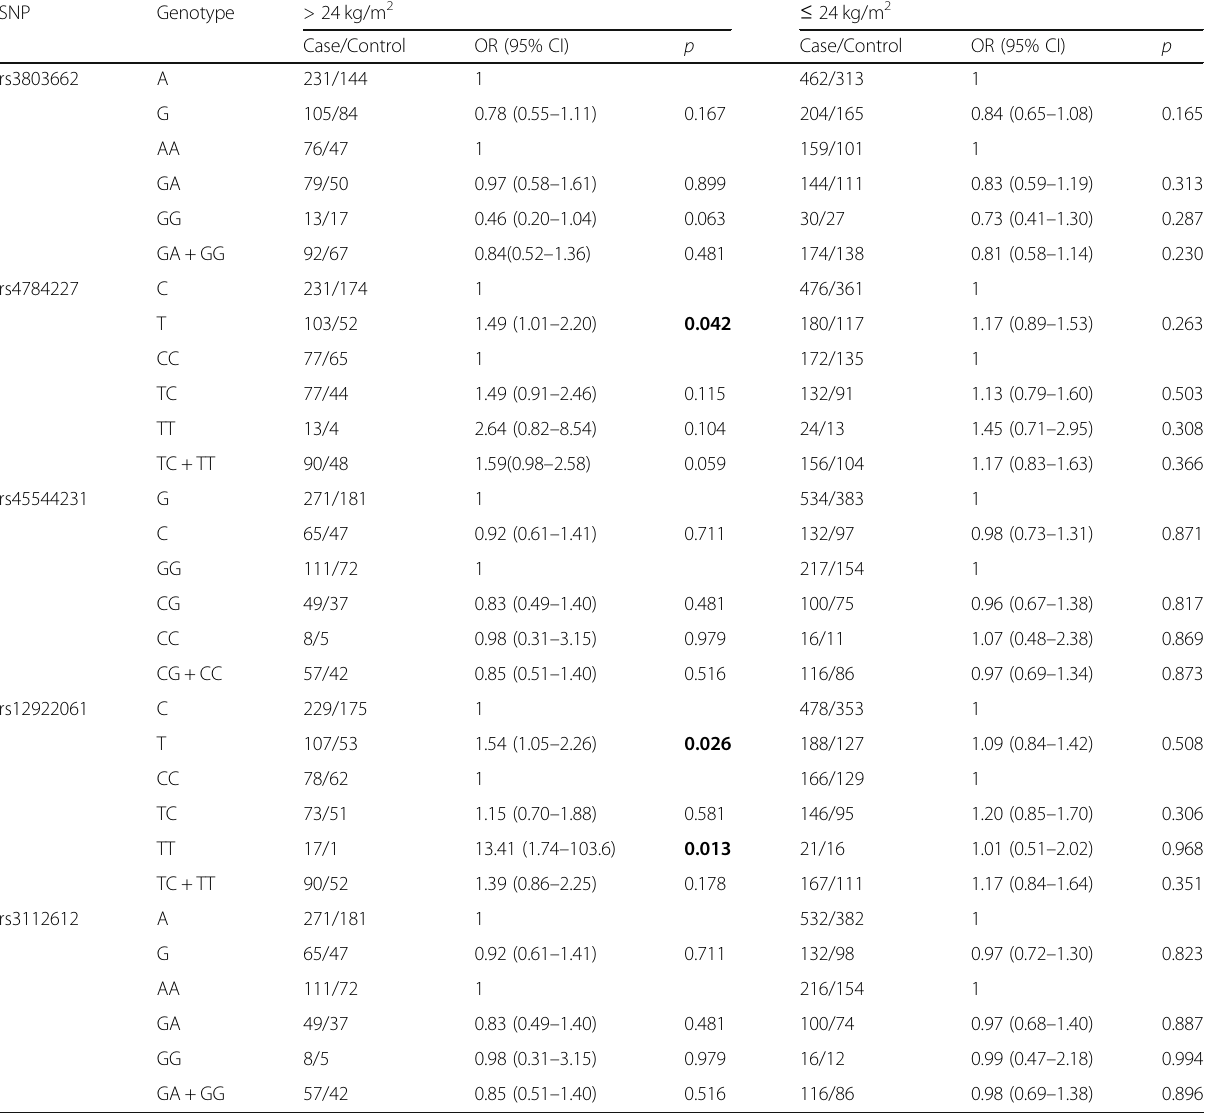
Table 6 The associations between CASC16 polymorphisms and BMI of breast cancer patients (adjusted by age and BMI)